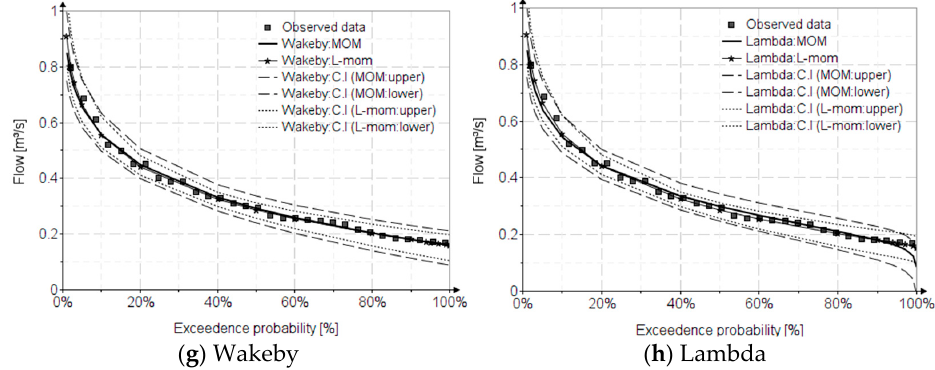
Figure 6. The probability distribution curves for minimum 1 ‐ day low flows.